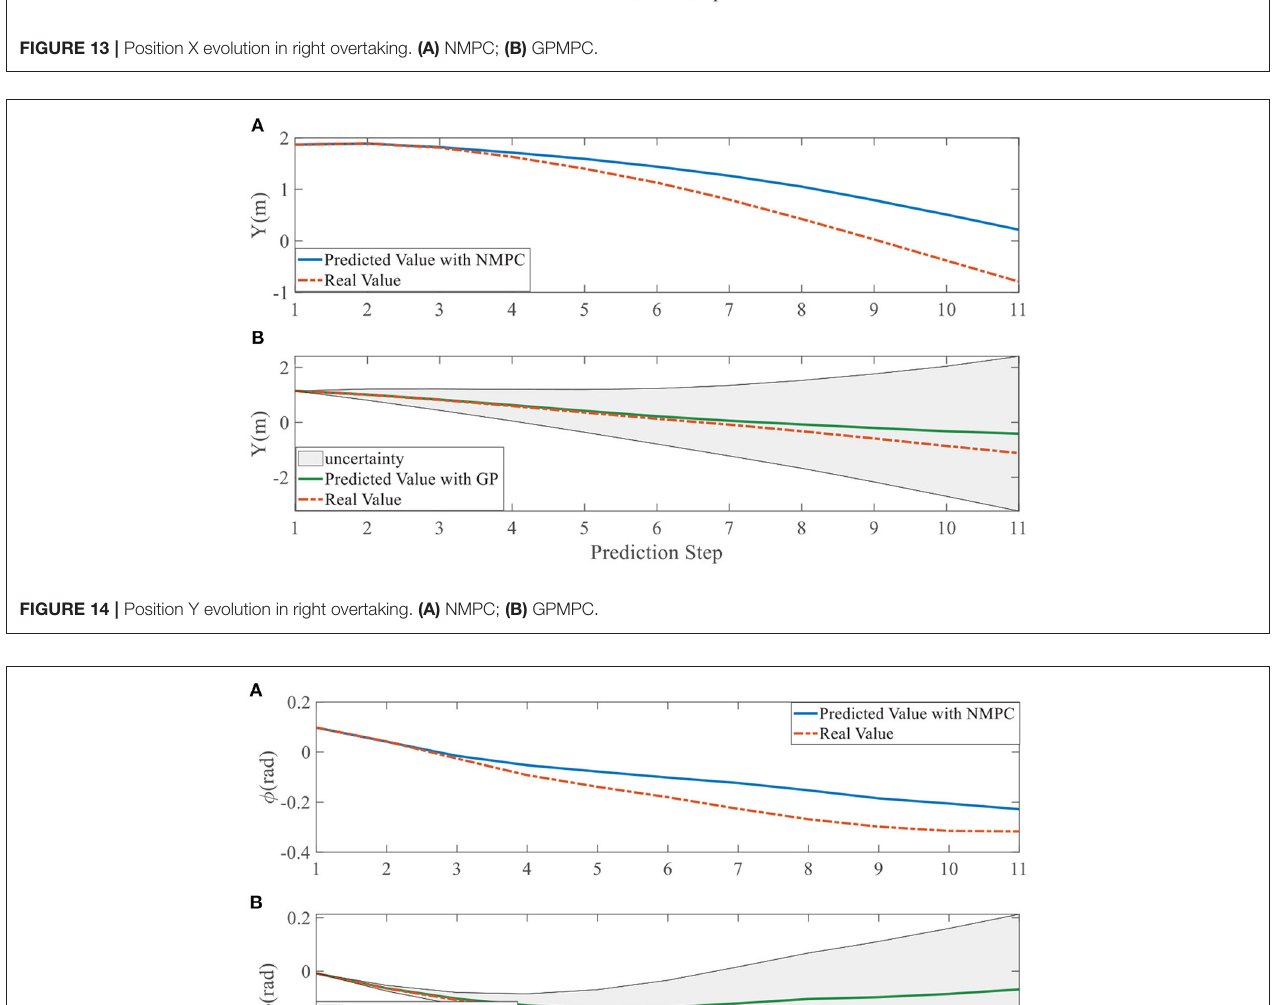
Frontiers in Neurorobotics |